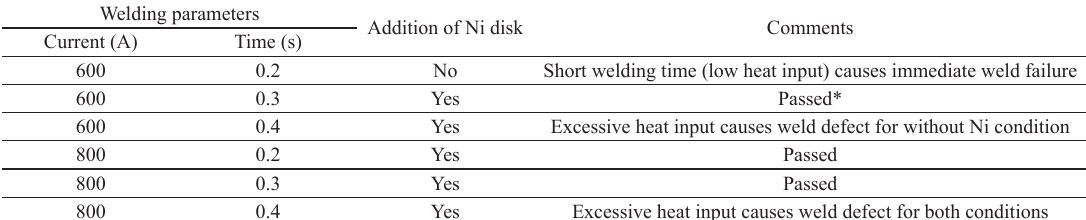
Table 3. Welding parameters and conditions used in this research Welding parameters